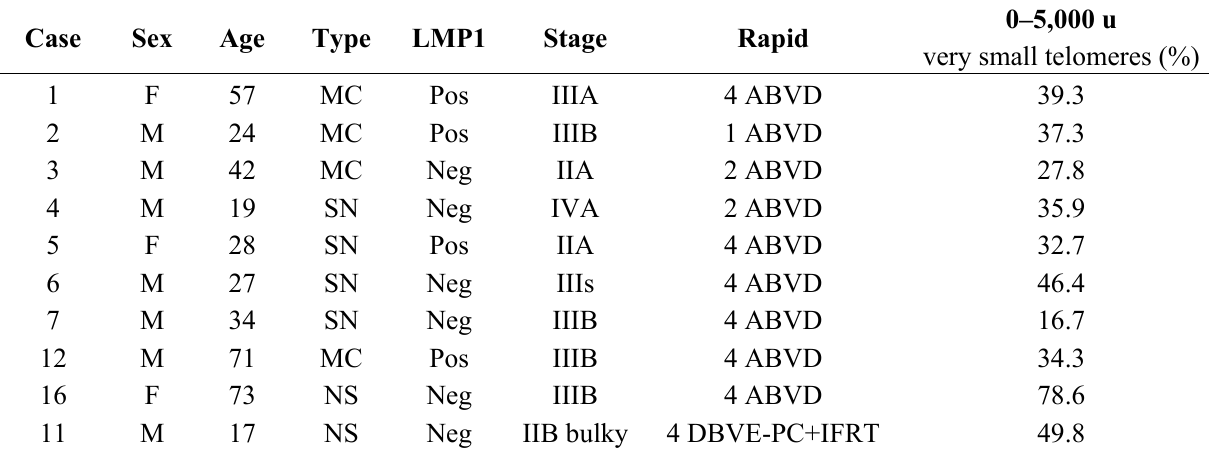
Table 1. Clinical data and percentage of very small telomeres of mononuclear Hodgkin cells at diagnosis (mean 39.9%) in patients with rapid and long ongoing remission (mean 57 months).